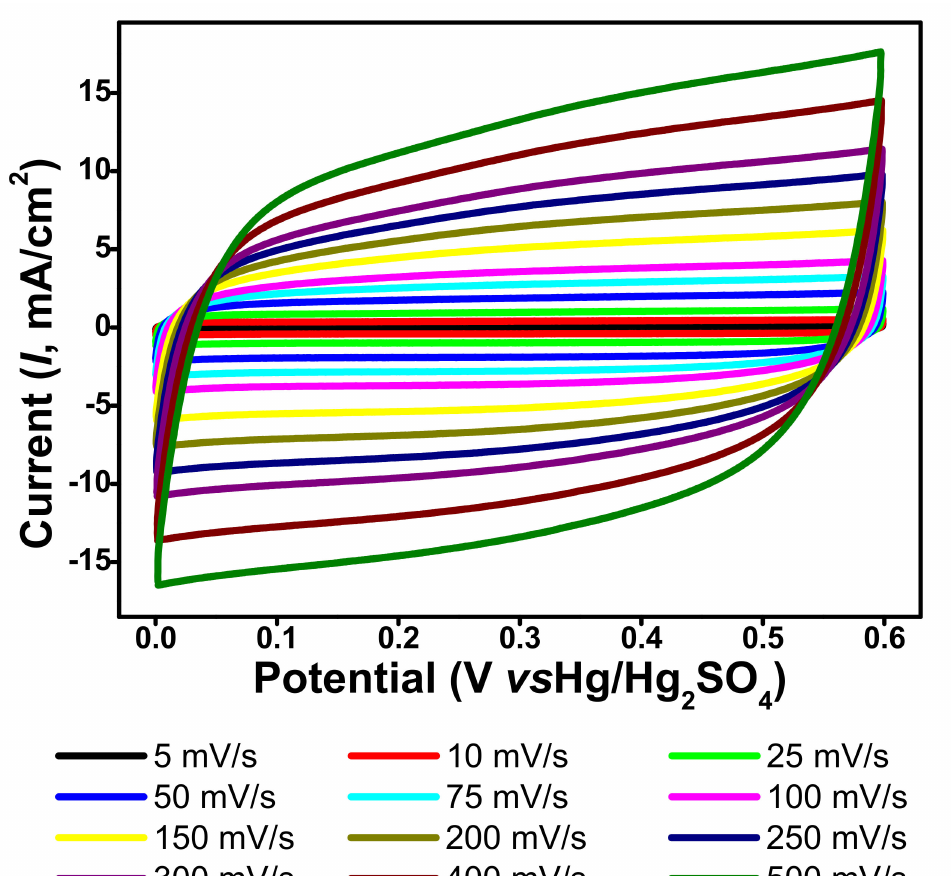
Figure 7. Cyclic voltammograms of GPNVP composite at various scan rates (5–500 mV/s) within the potential range from 0.0 to 0.6 V (vs. Hg/Hg 2 SO 4 ) in an aqueous 1 M H 2 SO 4